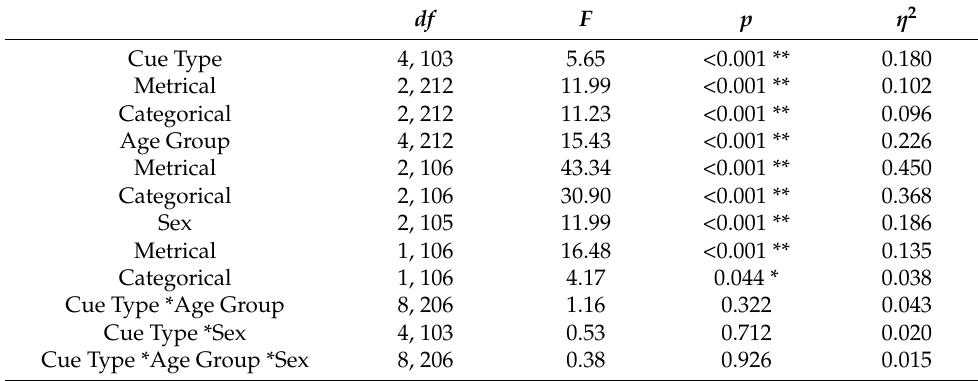
Table 4. Repeated measures MANOVA on Cue